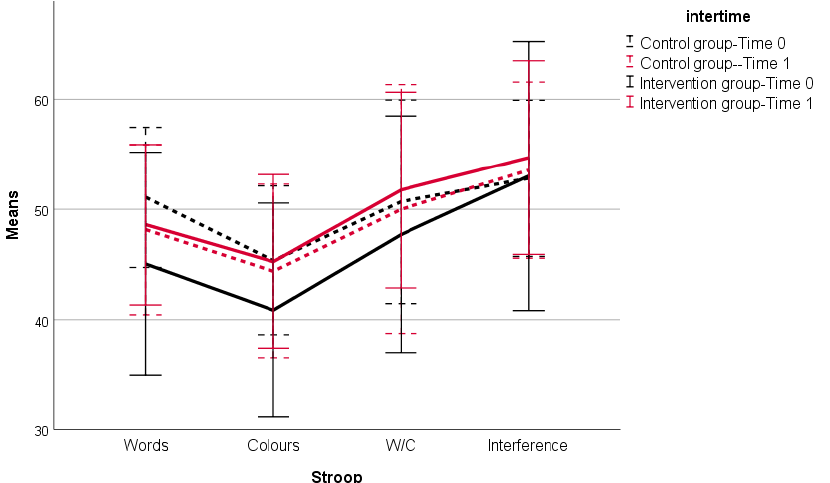
Figure 1. Graph representing the interaction between the experimental groups and time with respect to TL. The points represent the adjusted means by weight change and % fat change. The 95% confidence intervals for the adjusted means are also represented. Time 1: telomere length values at the end of the intervention in both groups. Time 2: telomere length values 6 months after completion of the intervention.